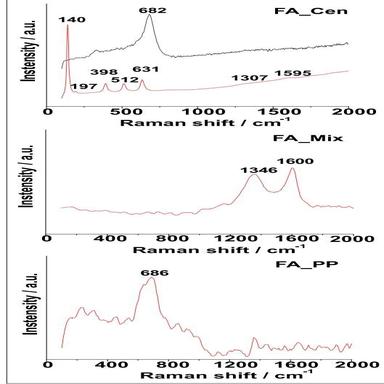
Raman spectra collected for FA_Mix, FA_PP and FA_Cen samples.